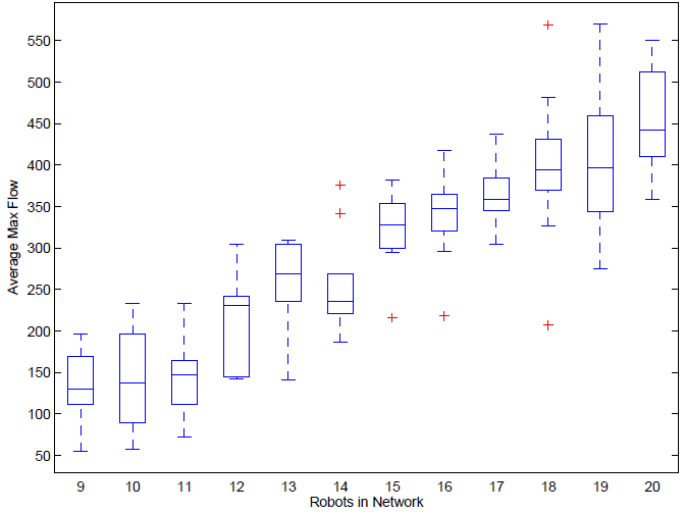
Figure 16. Average maximum flow with participation of 9 to 21